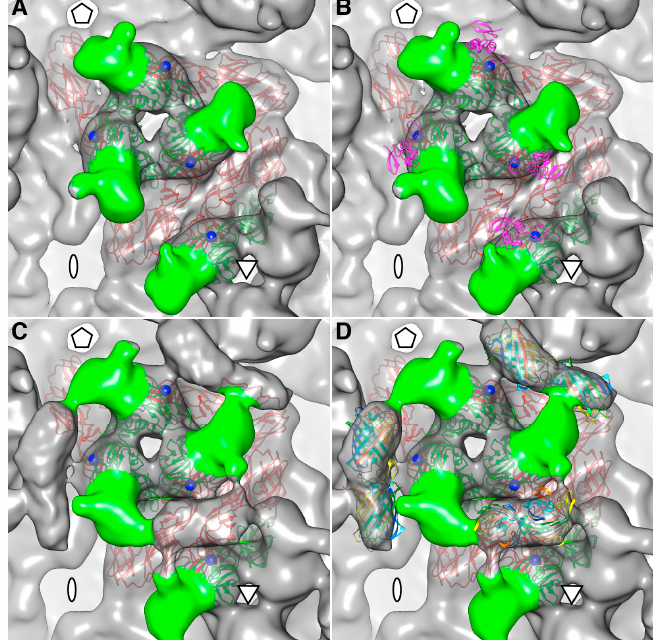
Figure 4. Comparison of mCherry-E2 and WT SINV spike structures. The asymmetric unit of the icosahedral reconstruction is shown with five-, two-, and three-fold axes labeled with a pentagon, oval, and triangle, respectively. The E1 and E2 glycoprotein models in ribbon structures are colored red and green, respectively. The N-terminal residue in each E2 is marked with a blue sphere and the E2 receptor-binding domain represented by the surface structure is colored green. ( A ) WT virus spike; ( B ) WT spike showing the location of E3 on the glycoprotein spike by adding a ribbon structure of E3 (magenta) to the glycoprotein model to show its potential location on the virus surface where the mCherry tag is cloned; ( C ) mCherry-E2 virus spike with extra mCherry densities between the spikes next to the N-termini of E2; ( D ) mCherry-E2 virus spike fitted with the red fluorescent protein (RFP) dimer (rainbow-colored ribbon structure from N- to C-termini) between two neighboring E2 subunits across the spikes.